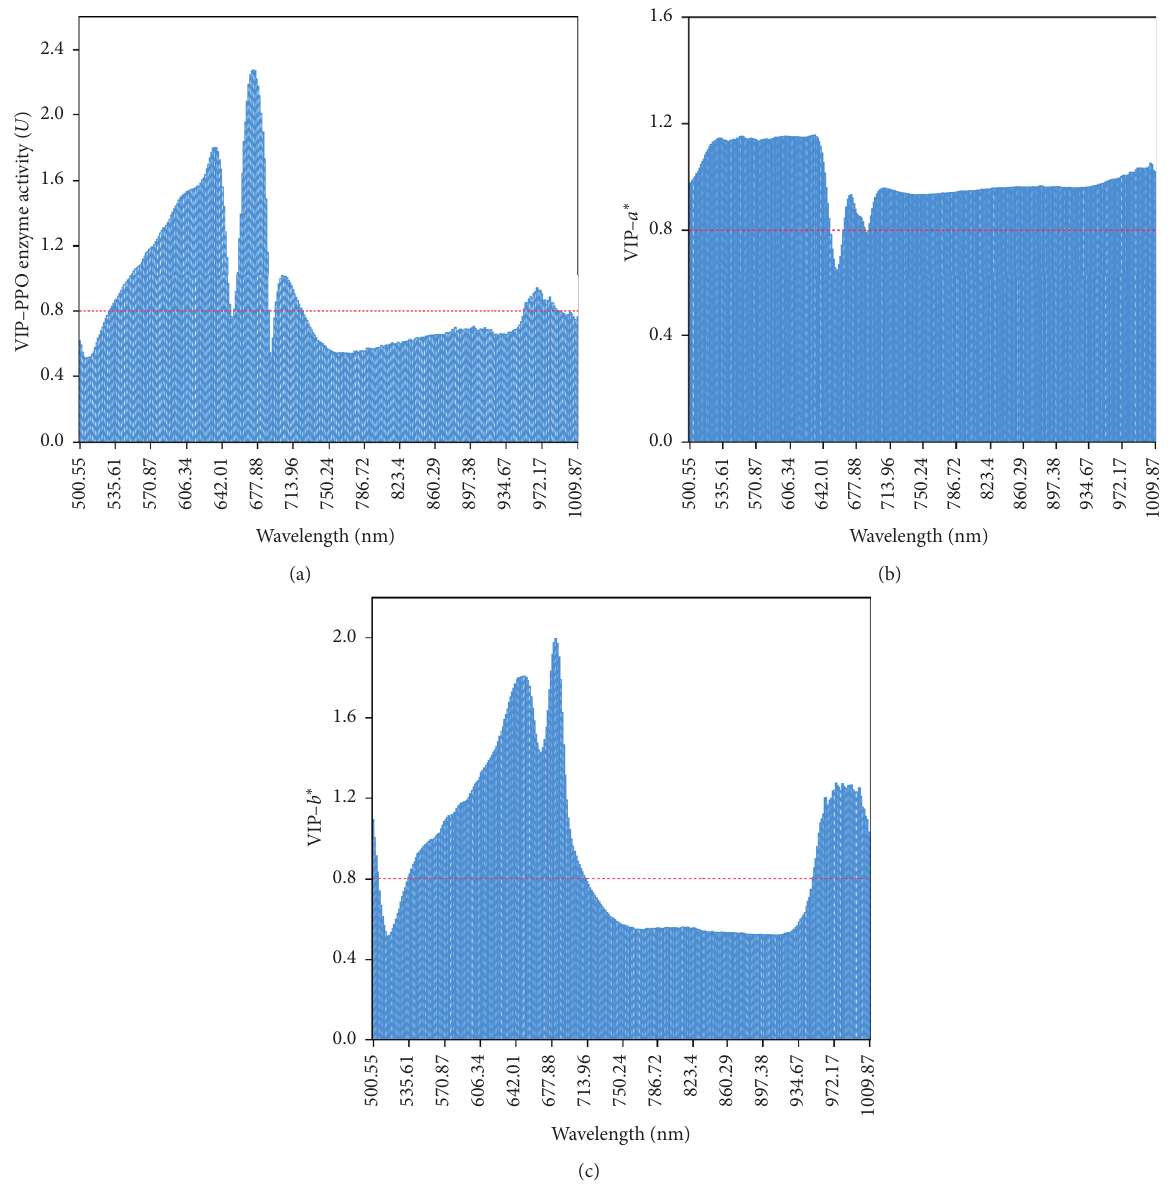
Figure 2: VIP plot for PPO activity (a), a ∗ (b), and b ∗ (c) as a function of